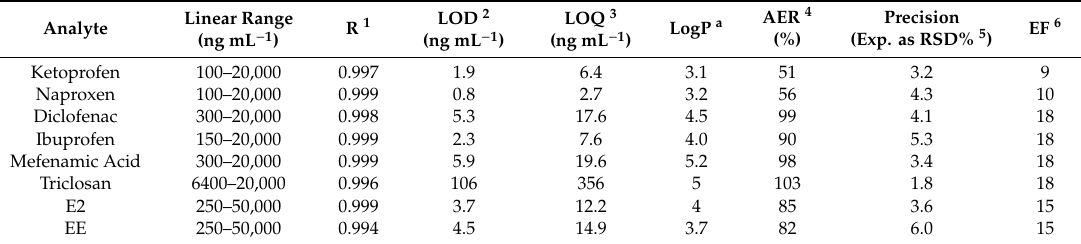
Table 1. Analytical features for the extraction of emerging contaminants by SHS-homogeneous liquid–liquid microextraction (HLLME).